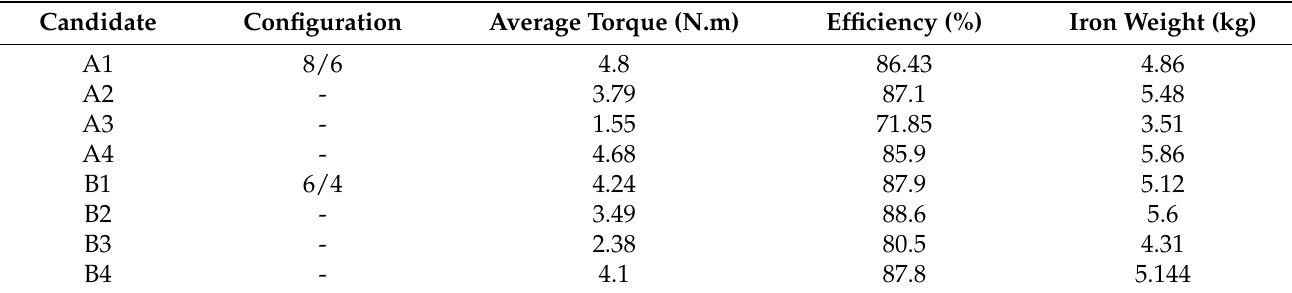
Table 3. Chosen optimal candidates.